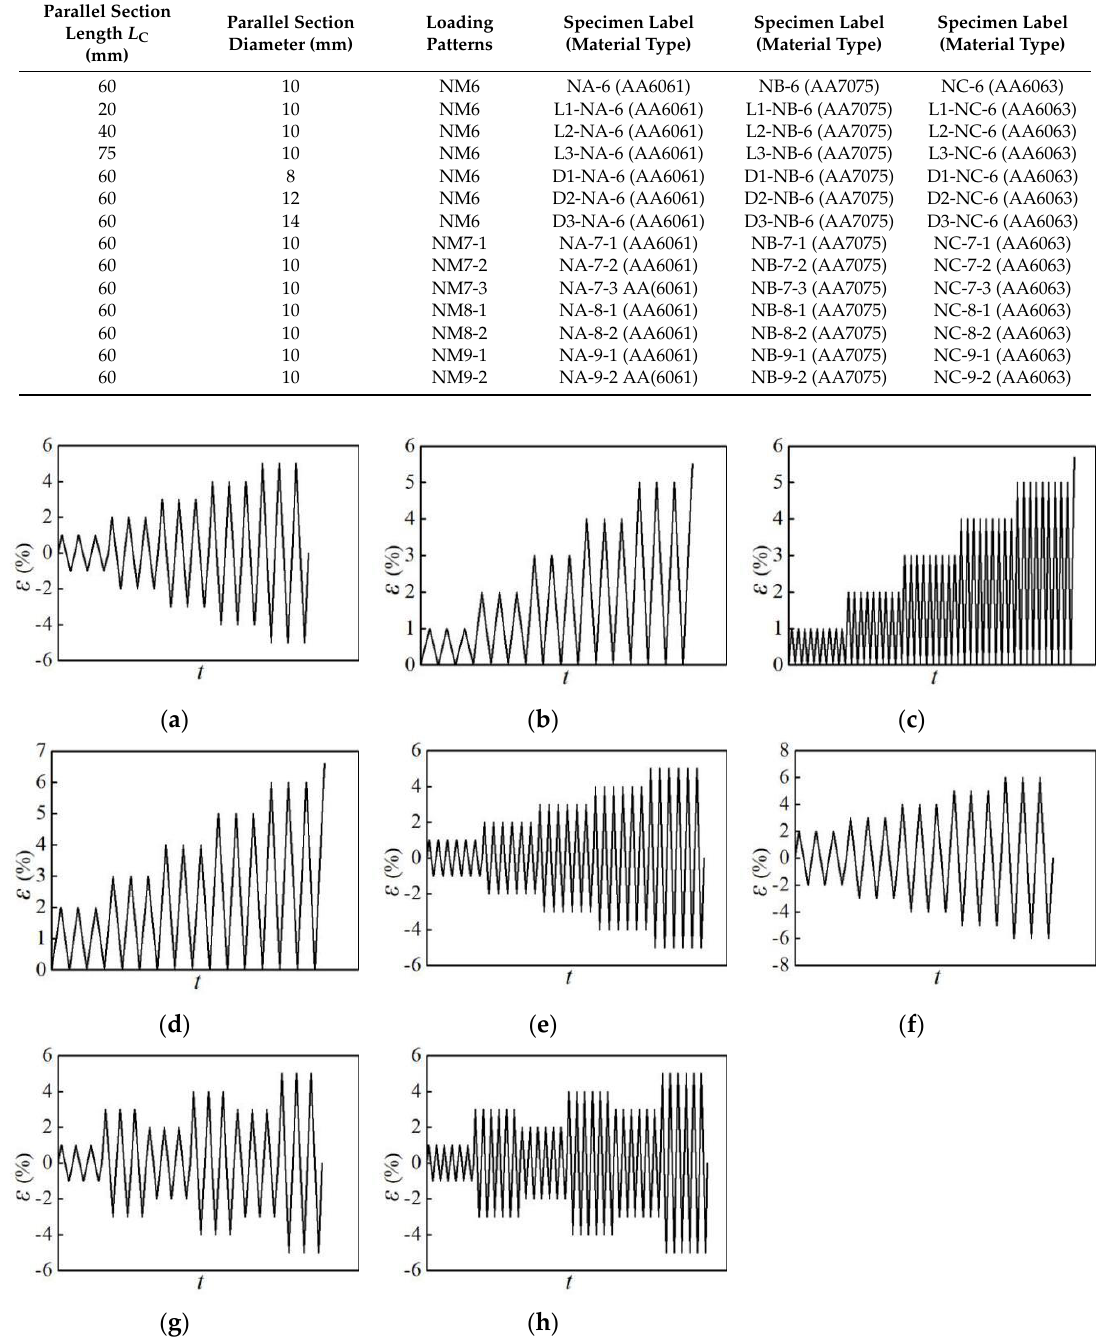
Figure 14. Loading patterns of specimens for the numerical analysis (Units: s): ( a ) loading pattern NM-6; ( b ) loading pattern NM-7-1; ( c ) loading pattern NM-7-2; ( d ) loading pattern NM-7-3; ( e ) loading pattern NM-8-1; ( f ) loading pattern NM-8-2; ( g ) loading pattern NM-9-1; ( h ) loading pattern NM-9-2.